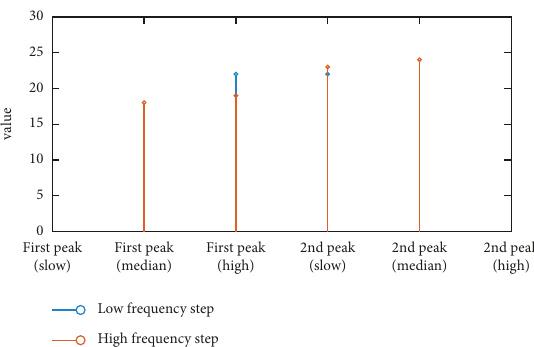
Figure 3: Analysis of kinetic parameters at different